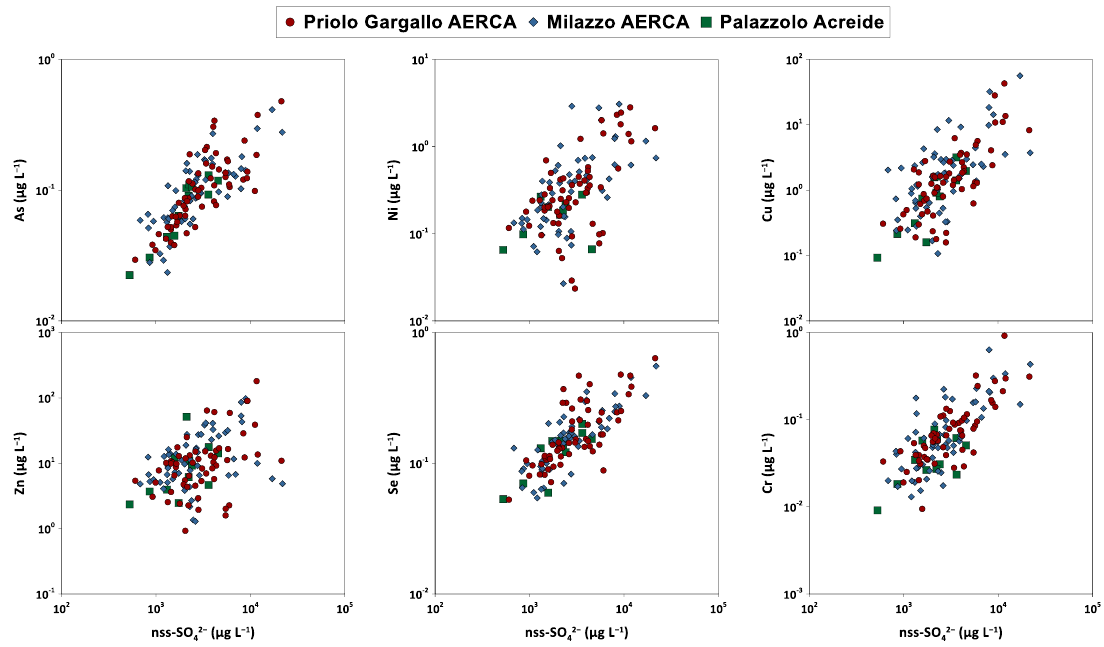
Figure 5. Correlation between some trace elements emitted by industrial plants of the two study areas (μg L −1 ) as reported by ARPA Sicilia [61], and nss-SO 42 − (μg L −1 ). The highest Pearson’s coefficient of correlation was obtained for arsenic in the Palazzolo Acreide area (r = 0.845, p = 0.0005). A good correlation was also observed for selenium at Milazzo AERCA (r = 0.838, p < 0.0001), Palazzolo Acreide site (r = 0.762, p = 0.004), and Priolo Gargallo AERCA (r = 0.733, p < 0.0001). For copper, the highest coeffi- cient of correlation was obtained for the Palazzolo Acreide site (r = 0.800, p = 0.002). For nickel, the highest coefficient of correlation was found in the Priolo Gargallo AERCA (r = 0.703, p < 0.0001). In all three areas, the lowest correlation was found for zinc with r values of 0.445 ( p = 0.004), 0.272 ( p = 0.037), and 0.210 ( p = 0.512) for Priolo Gargallo AERCA, Milazzo AERCA, and Palazzolo Acreide, respectively. Therefore, these elements in the atmospheric deposition of all the study areas should not be considered exclusively of anthropogenic origin, but other sources, probably geo- genic and marine, may contribute to their enrichment in the atmosphere. Similar results were obtained by considering the concentrations of the same elements determined from the analysis of the unfiltered aliquot. As reported in Brugnone et al., 2023a [47], one of the most important sources of the deposited elements and compounds, especially in the area of Priolo Gargallo AERCA and Milazzo AERCA and to a lesser extent in Palazzolo Acreide, is the marine source. One of the major indicator ions of the marine source is chloride. A positive linear correlation was observed between chloride and boron, with a coefficient of correlation values of 0.796 ( p < 0.0001), 0.691 ( p < 0.0001) and 0.652 ( p = 0.022) for the Milazzo AERCA, Priolo Gargallo AERCA, and the Palazzolo Acreide site, respectively. Furthermore, the B/Cl ratio of the samples takes values close to that of seawater with increasing Cl content (Figure 6). There- fore, the sea is a plausible source for a significant part of the boron present in the analysed samples. Another trace element present in high abundance in seawater was strontium. The best correlation, although not high, was shown for the Milazzo area (r = 0.467; p = 0.0002). Even for this trace element the contribution from the marine source was not neg- ligible, but other sources must be called in to explain the enrichment in strontium that was observed, relative to chloride, at all monitoring sites. (Figure 6).